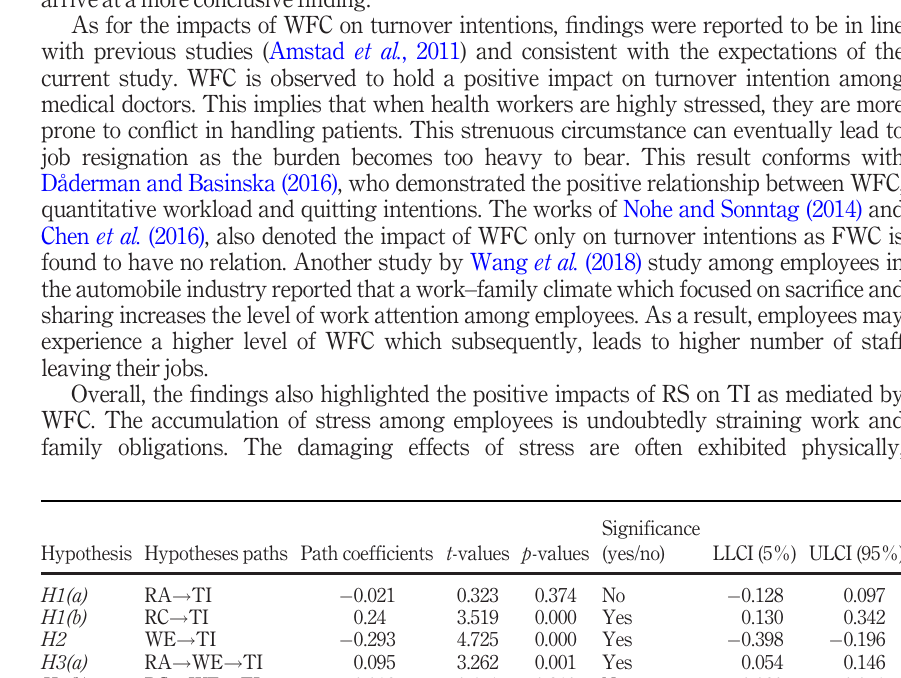
hypotheses tests based on PLS-SEM based